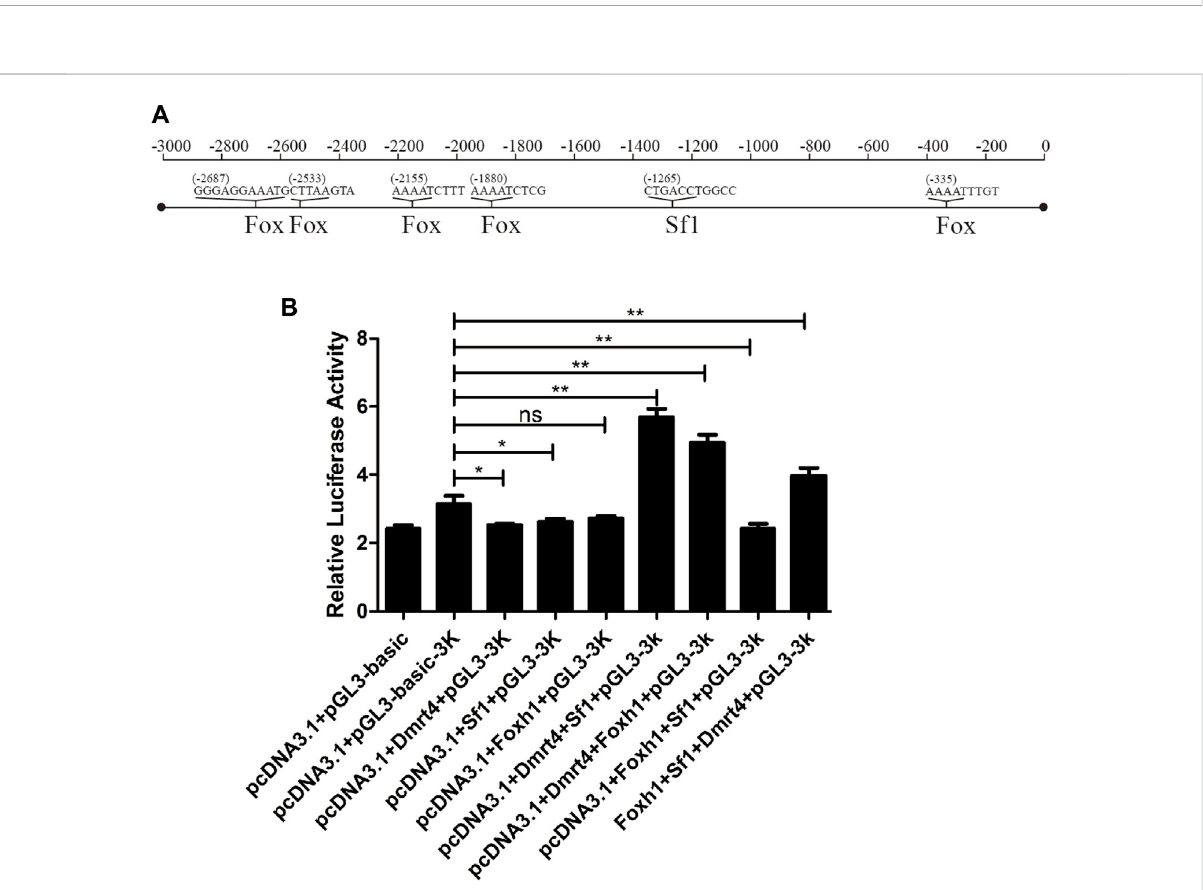
Regulation experimentof 42Sp50 promoter invitro . (A) The binding sitesof 42Sp50 promoterwith Sf1 and Fox genefamilymembers predicted by PROMO. (B) Luciferase analysis to detect the regulatory effects of Sf1 , Foxh1 , and Dmrt4 and their combinations on the promoter of 42Sp50